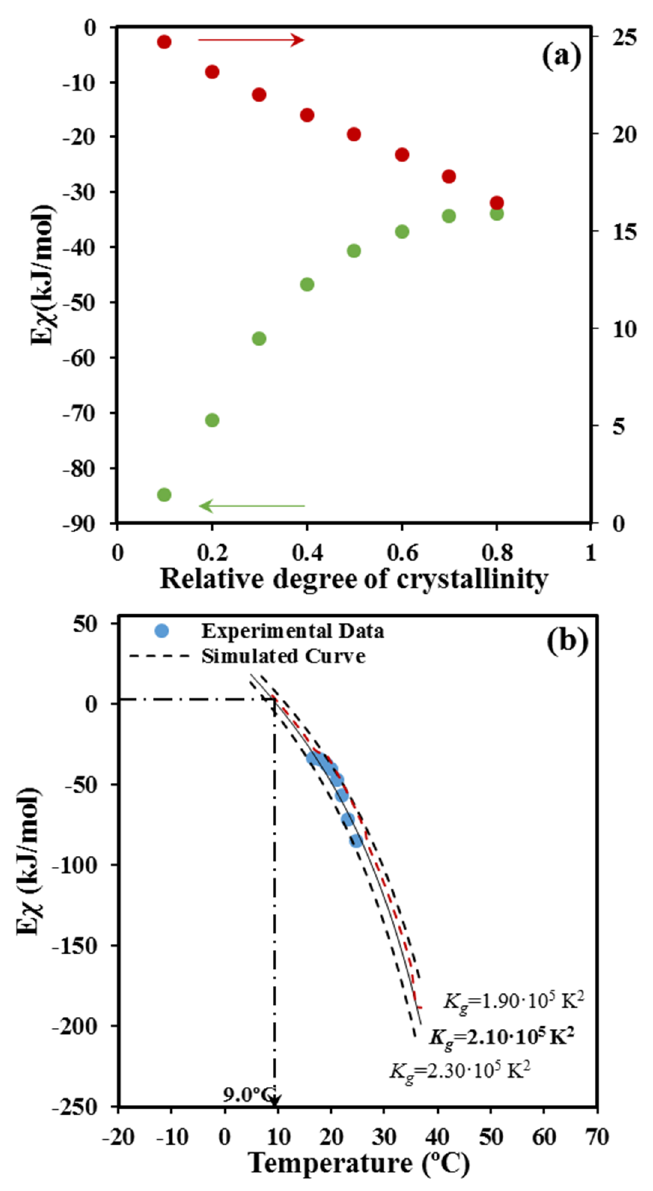
Figure 9. ( a ) Dependence of the activation energy of crystallization ( ● ) and the average crystallization temperature ( ● ) on crystallinity. ( b ) Experimental Ex vs. T data for non-isothermal crystallization of P4HB. The solid black line corresponds to the data calculated by Equation 11 and the optimized crystallization parameters. Arrow indicates the expected temperature for the maximum crystallization rate (i.e., the effective activation energy becomes equal to zero).